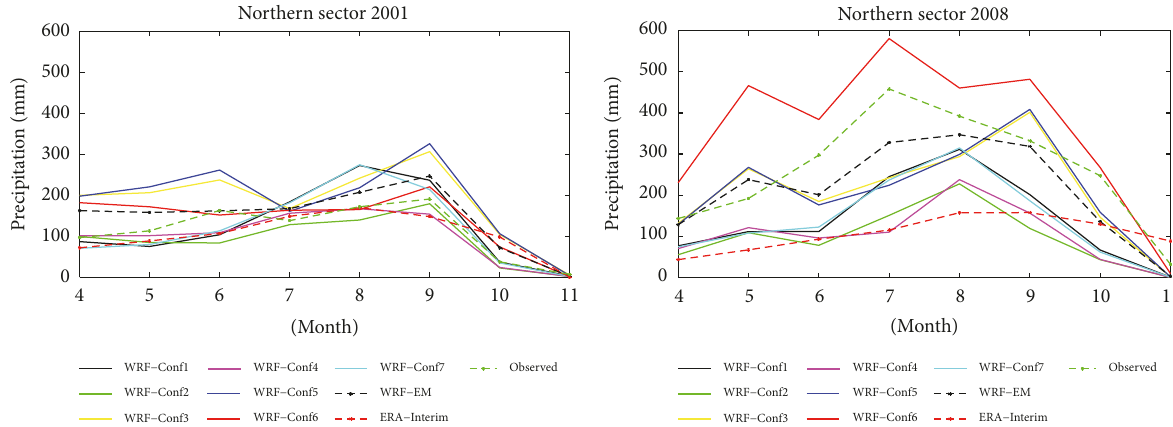
Figure 10: Time series plots of monthly total precipitation simulated for the northern sector of Ghana for the dry year (2001) and wet year